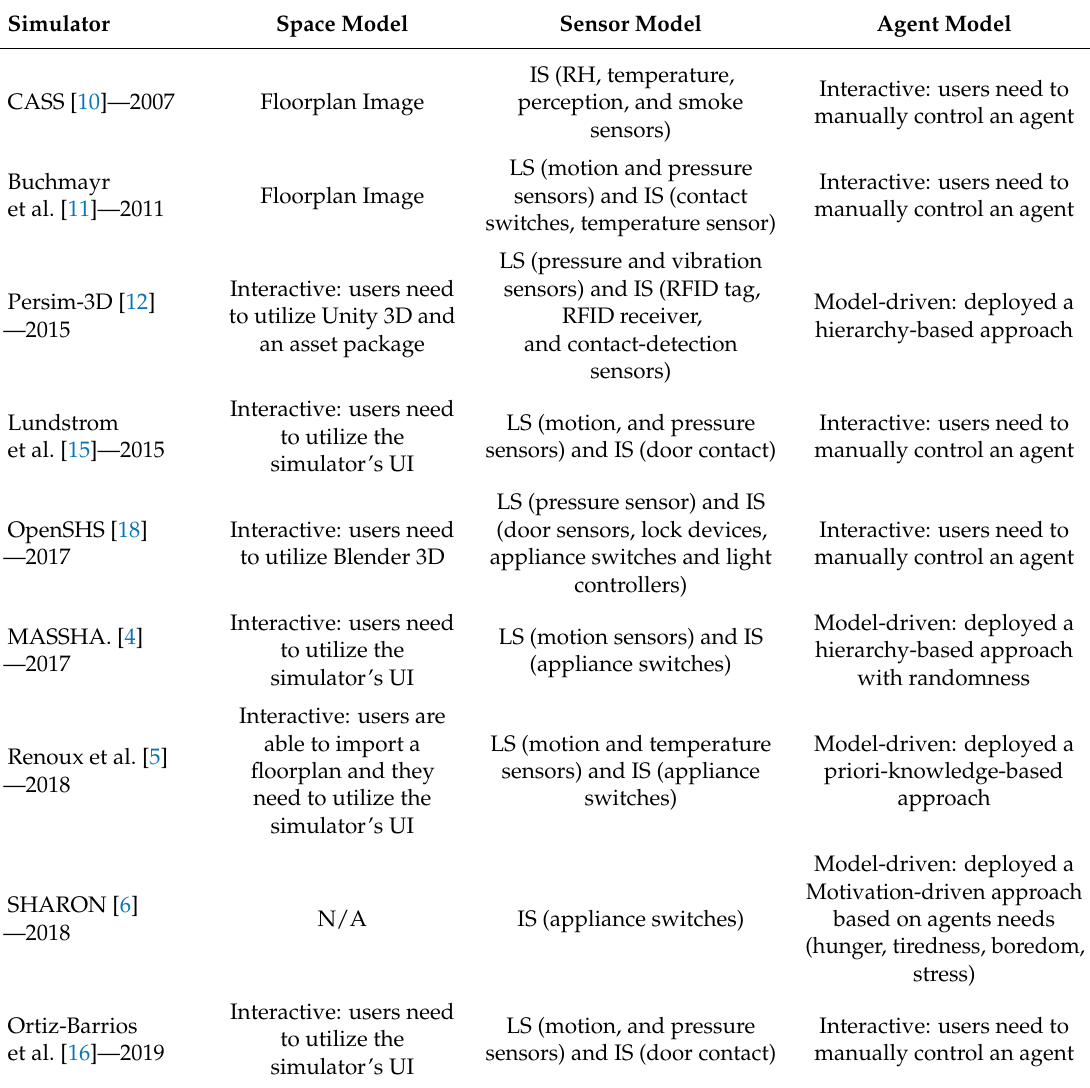
Table 1. Existing smart indoor space